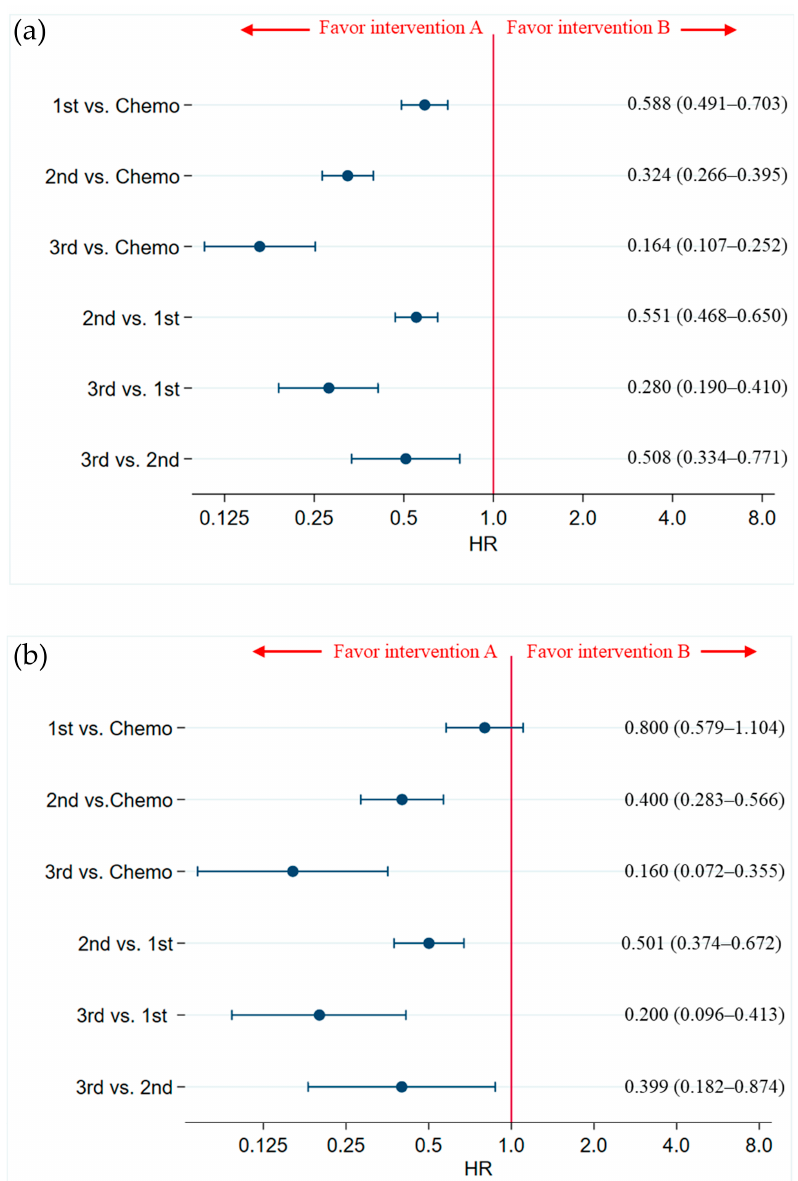
Figure 5. Comparison of the efficacies of chemotherapy, first-generation ALK inhibitors (crizotinib), second-generation ALK inhibitors (ceritinib, alectinib, brigatinib, and ensartinib), and third- generation ALK inhibitors (lorlatinib) in prolonging the PFS of ( a ) overall patients with ALK-p, ALK inhibitor-naive advanced NSCLC and ( b ) a subgroup of patients with CNS metastases. Data are expressed as hazard ratios (HRs) and 95% credible intervals (CrIs); ALK, anaplastic lymphoma kinase; ALK-p, anaplastic lymphoma kinase rearrangement positive; NSCLC, non-small cell lung cancer; CNS, central nervous system.